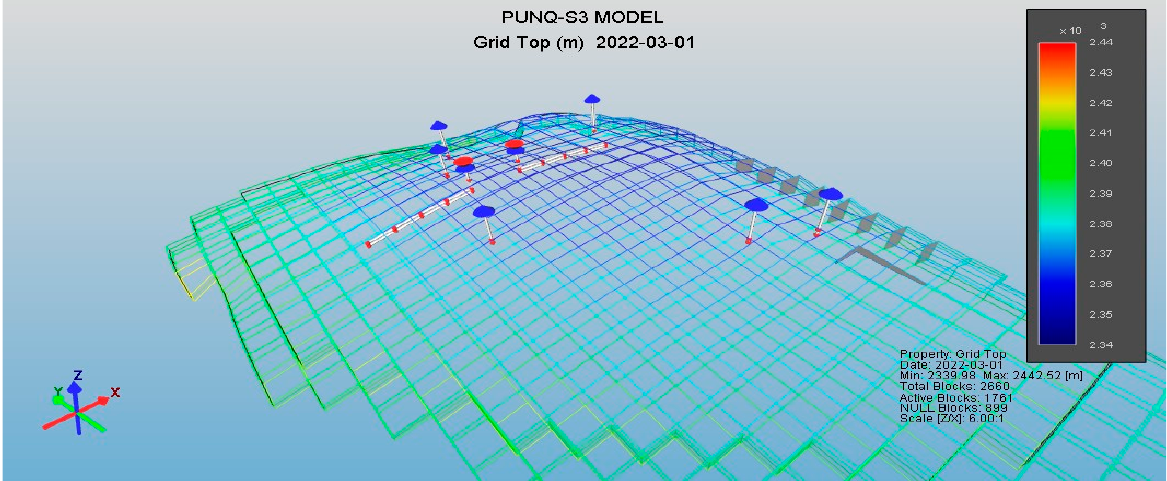
Figure 10. Well location optimization—scenario 1 for the PUNQ-S3 reservoir simulated with the TC-GDWS-AGD configuration.